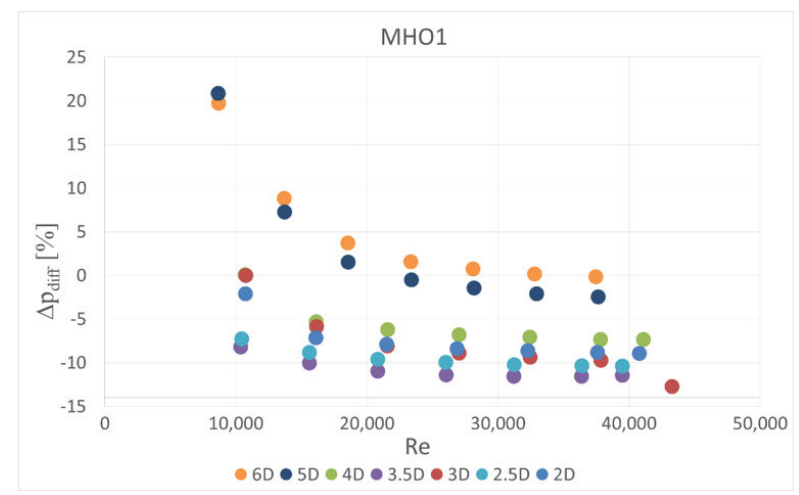
Figure 12. Pressure drop di ff erence for MHO1.